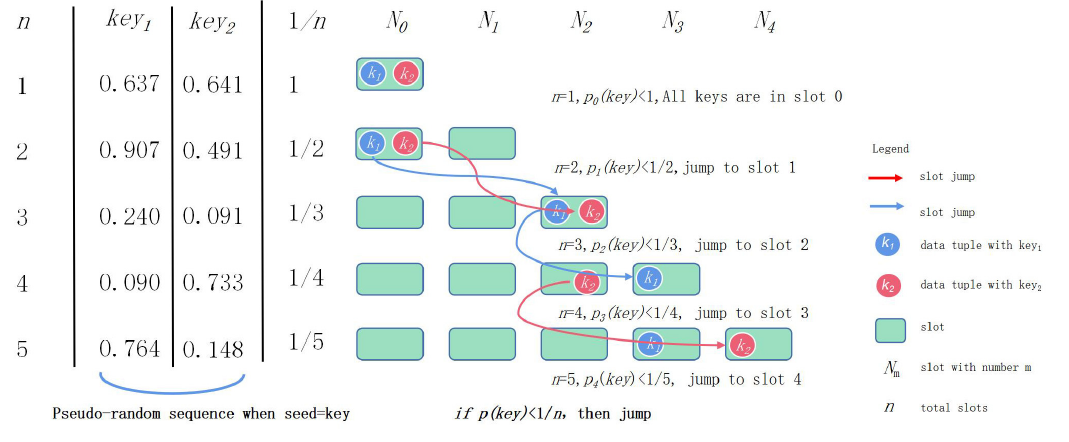
Figure 3. Jump consistent hash algorithm.